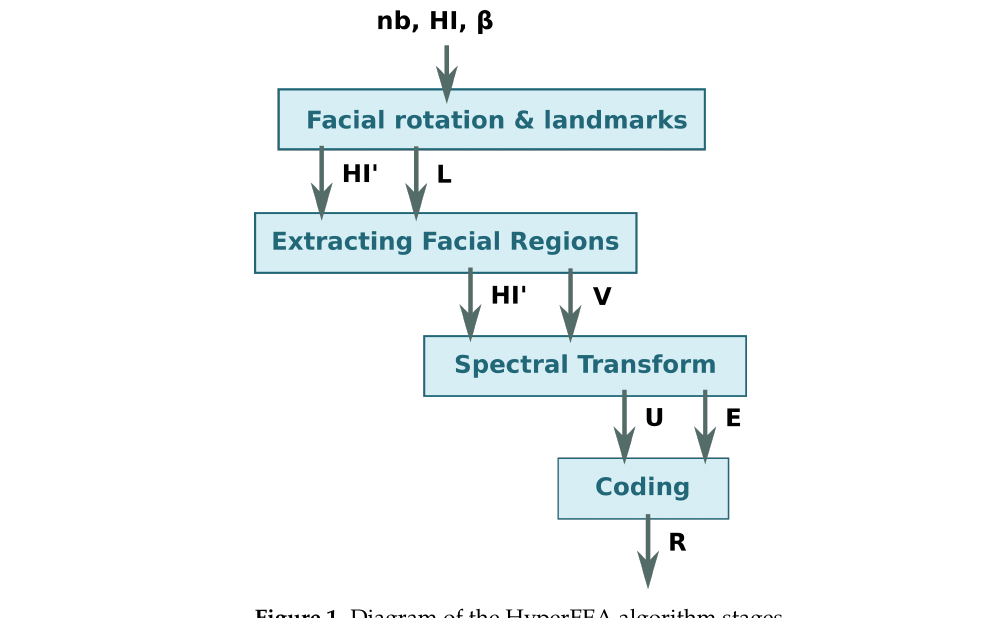
Figure 1. Diagram of the HyperFEA algorithm